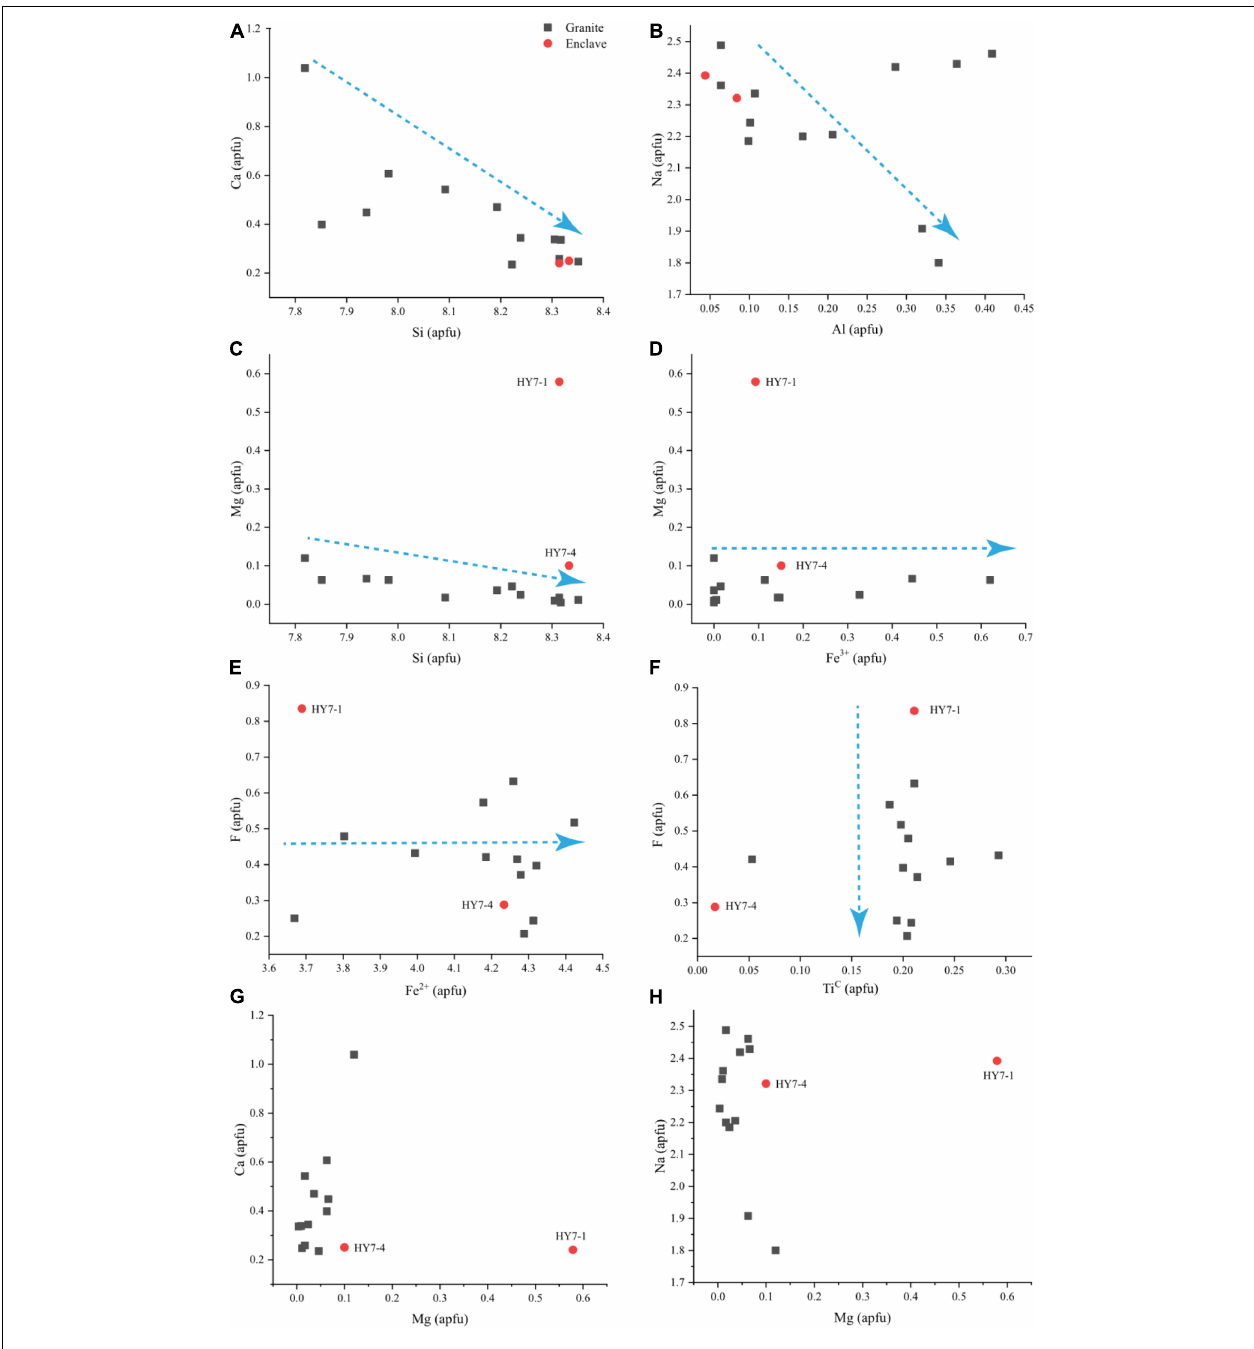
chemistry, they must show a negative correlation with